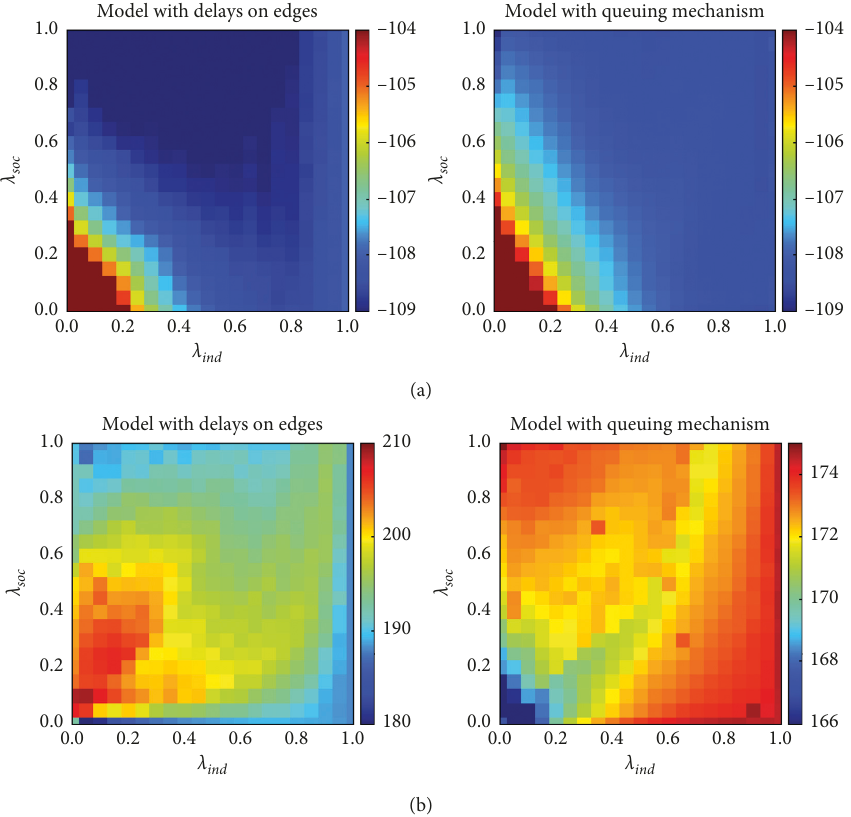
Figure 3: Aggregated results for expected arrival times. Each cell corresponds to single combination of λ for all simulation’s iterations which represents expected arrival time for all agents (a) and its standard deviation (b). Model with delays on edges